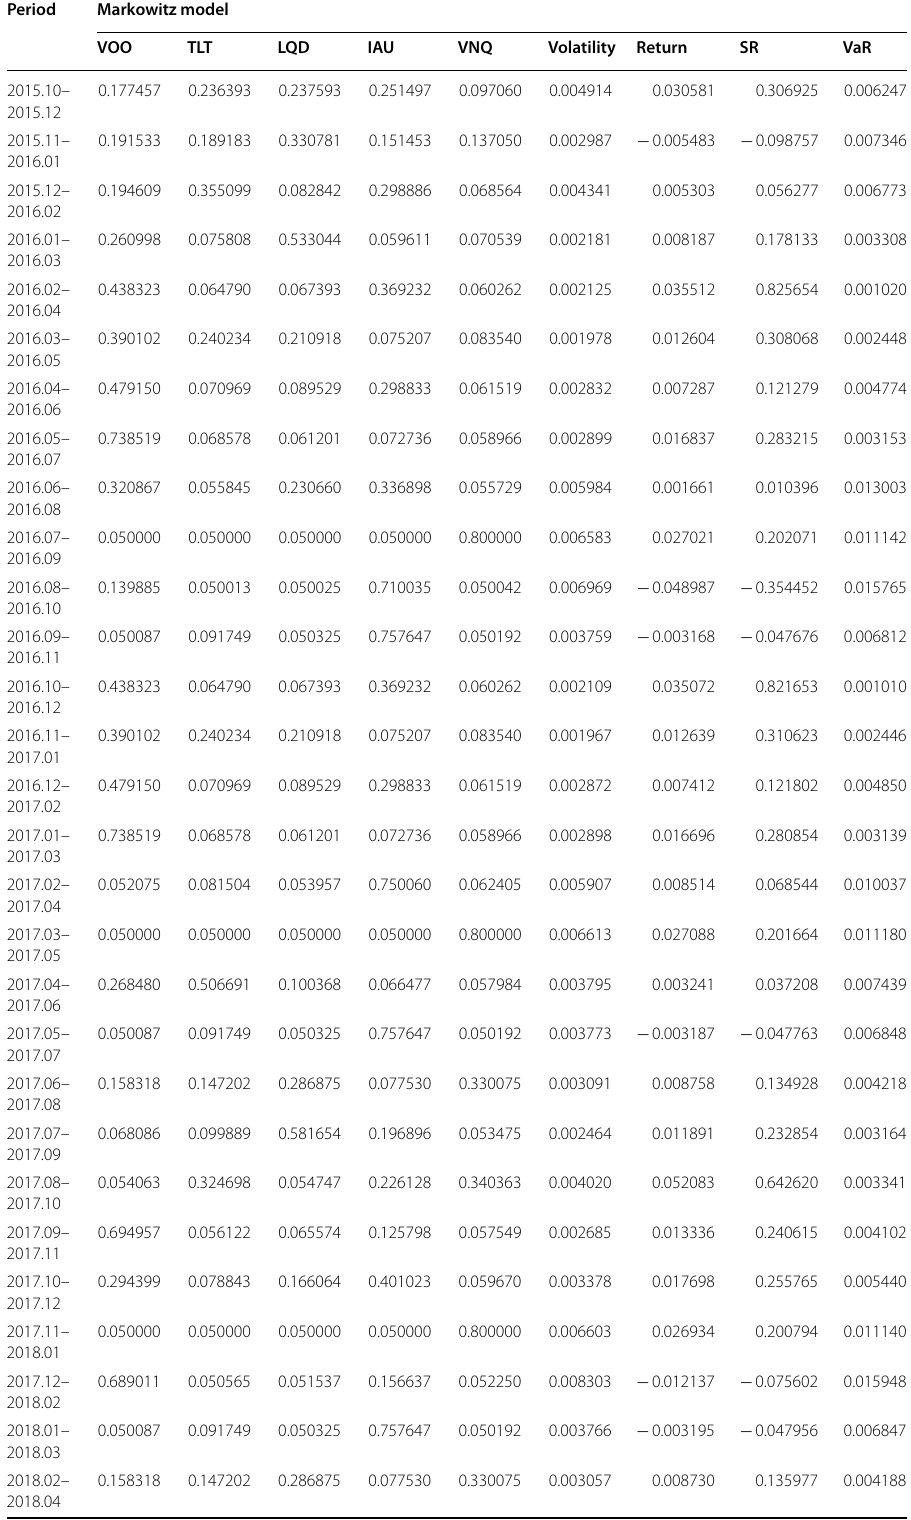
Table 2 The in‑sample results of Markowitz model and semiparametric method with VaR